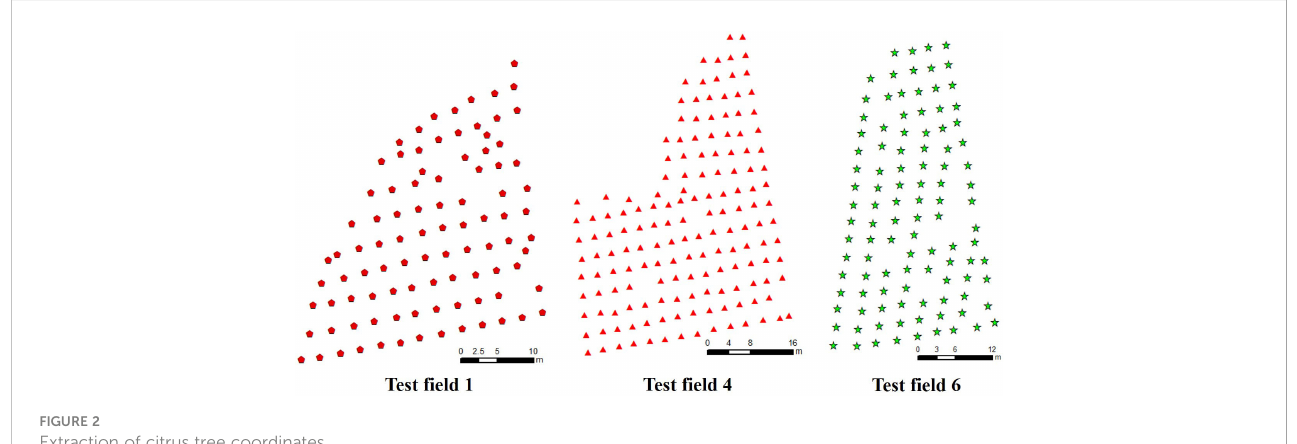
FIGURE 2 Extraction of citrus tree